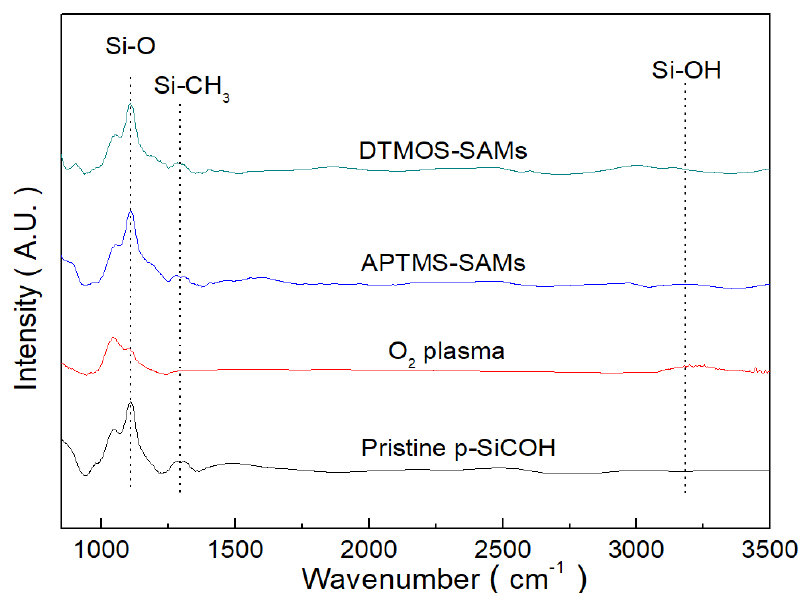
Figure 1. FT-IR spectra of pristine, O 2 plasma-irradiated, APTMS-SAMs, and DTMOS-SAMs p-SiOCH films.